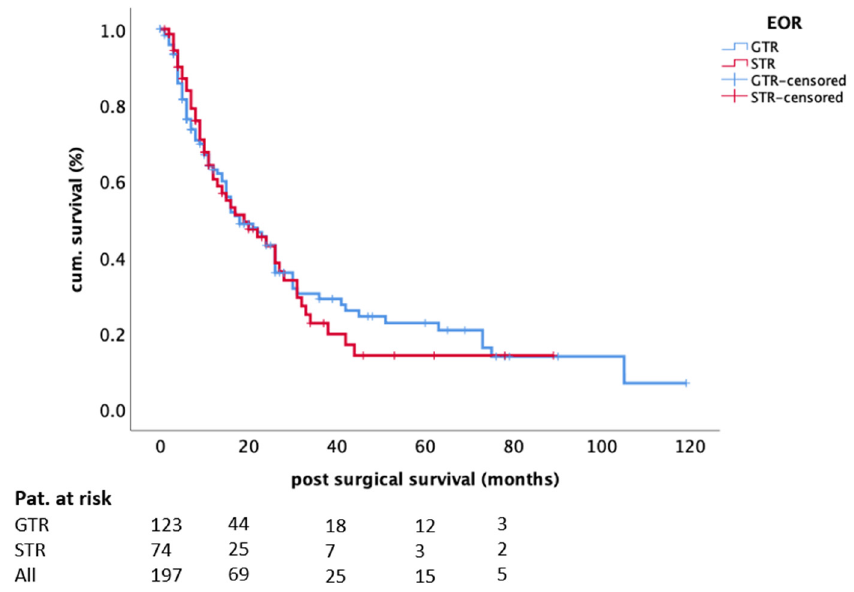
Figure 2. The influence of the extent of resection on OS. Kaplan–Meier plot ( n = 197; incom- plete/complete: 74/123; p = 0.759). Abbreviations: EOR—extent of resection, GTR—gross-total resection, STR—sub-total